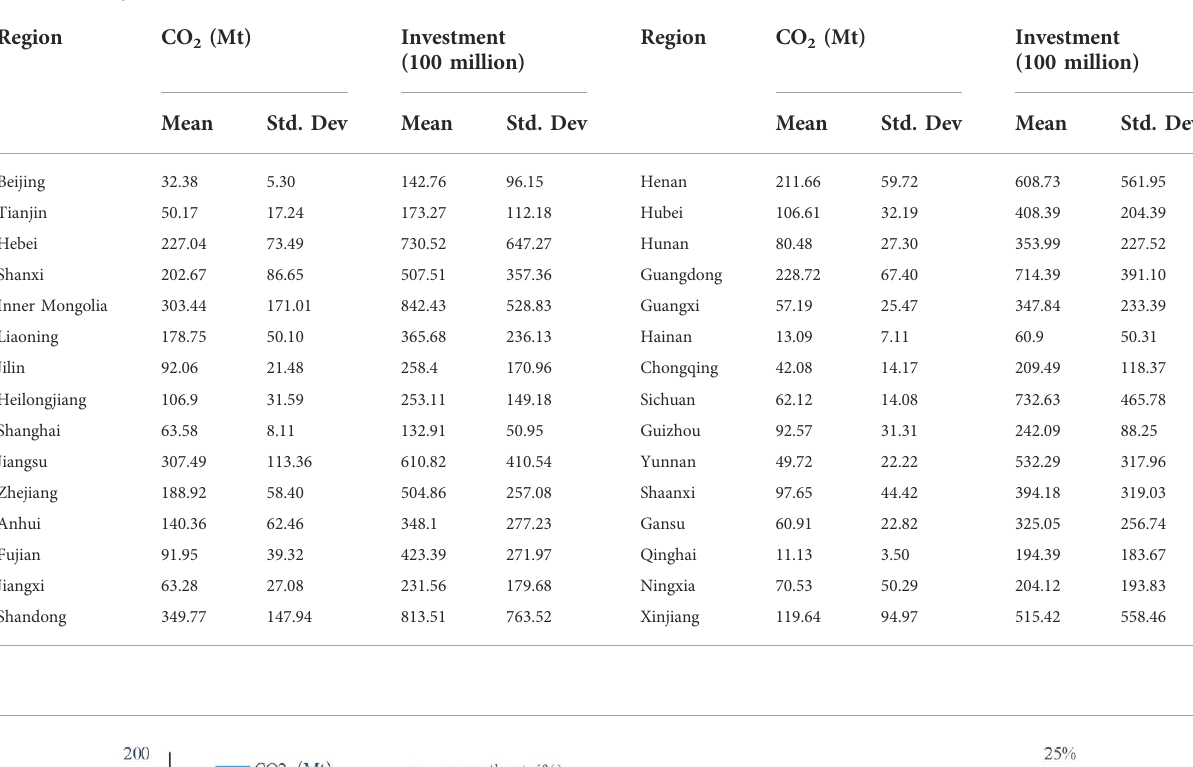
TABLE 2 Descriptive statistical results.